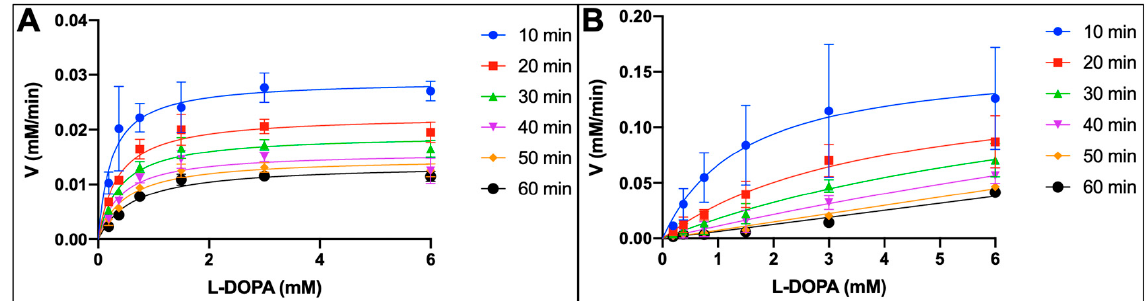
Figure 3. The maximum velocity (V max ) of diphenol oxidase reaction as a function of L-DOPA concentration for control and TYR-MB nanoparticles. ( A ) The control TYR. ( B ) TYR-MB nanoparticles. The measurement was repeated from 10 to 60 min at 10 min intervals. For each time point, the measurements of the V max were obtained in triplicates and averaged, and standard errors were calculated.